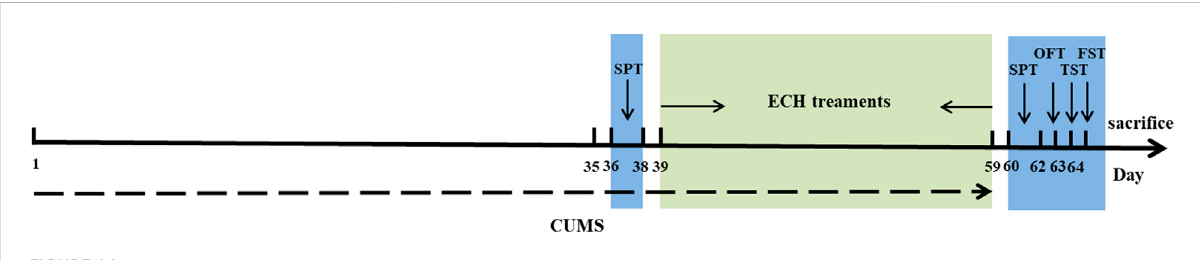
Schematic representation of timeline for echinacoside treatment in experimental animals with CUMS-induced